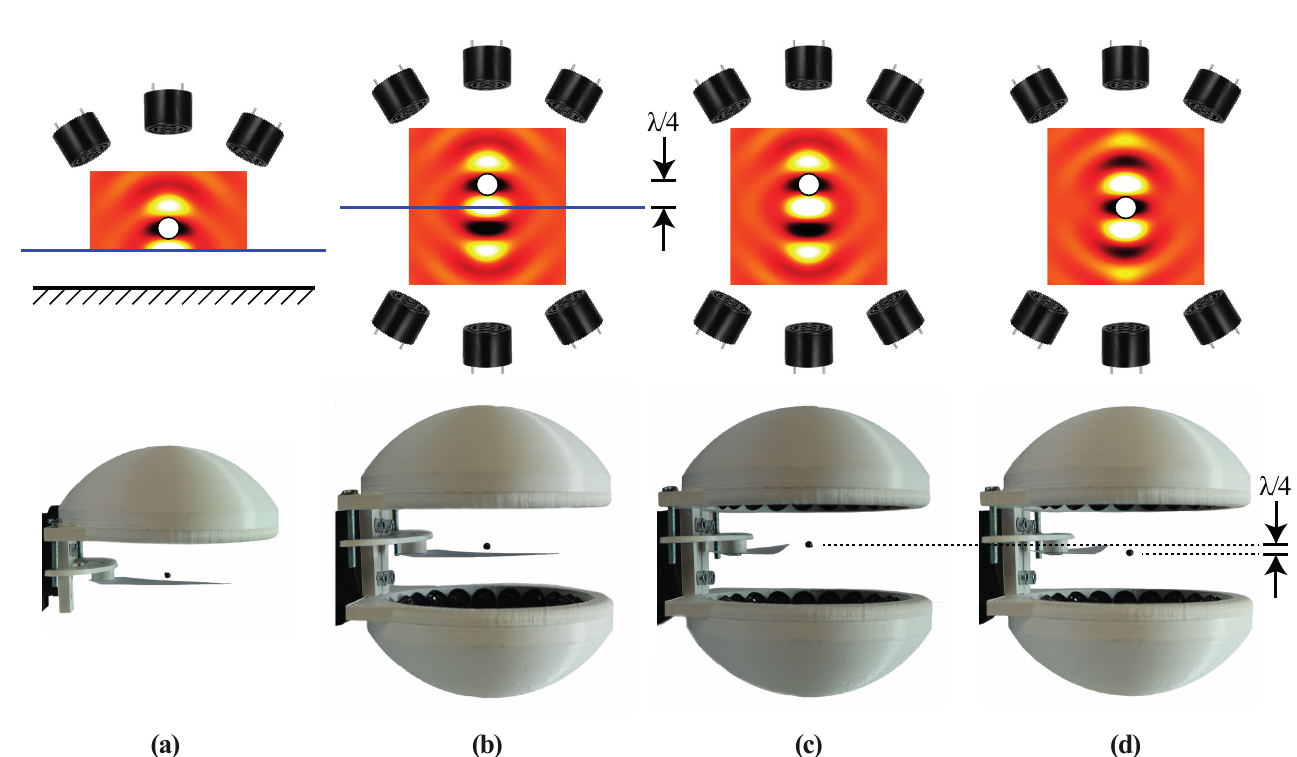
Figure 10. Insertion process of an object located on a acoustically reflective surface into a double-sided acoustic gripper. ( a ) The arrangement, the inserted reflector, and the levitating object are moved away from the reflective surface. ( b ) The second half of the double-sided arrangement is moved to the other side of the inserted reflector and the double-sided gripper is controlled such that a HTT is generated at z = λ /4. ( c ) The reflector can be removed and ( d ) the trap is moved to the center of the double-sided gripper. The shown elements correspond to those annotated in Figure